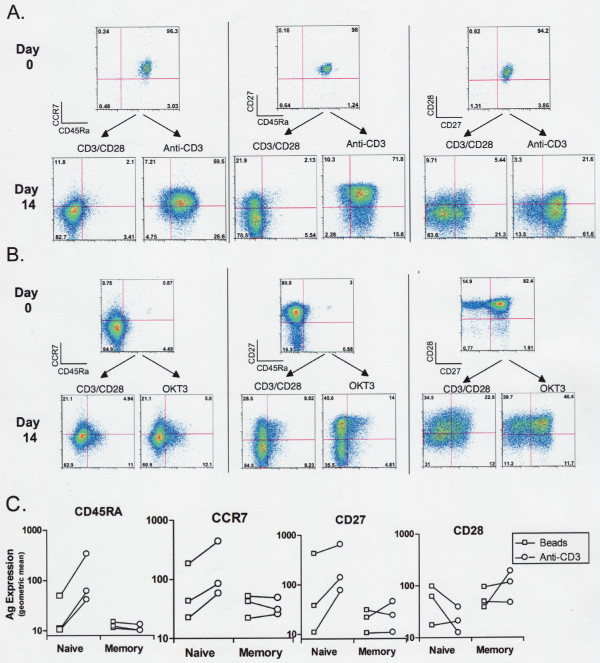
Comparison of the impact of anti-CD3/CD28 beads and soluble anti-CD3 plus irradiated MNCs on expansion by purified naive (A) and memory (B) CD8 cells. Significant differences in the phenotype of expanded naïve T cells, but not in memory cells, were noted. Panel C collates the results of 3 experiments quantitating changes in CD45RA, CCR7, CD27, and CD28 surface antigen (expressed as geometric mean channel fluorescence) when naïve and memoryCD8 cells were expanded using beads (squares) or anti-CD3/MNCs(circles) for 14 days.